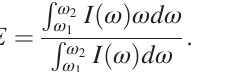
¼ 91 K). (c),(f) Overdoped c